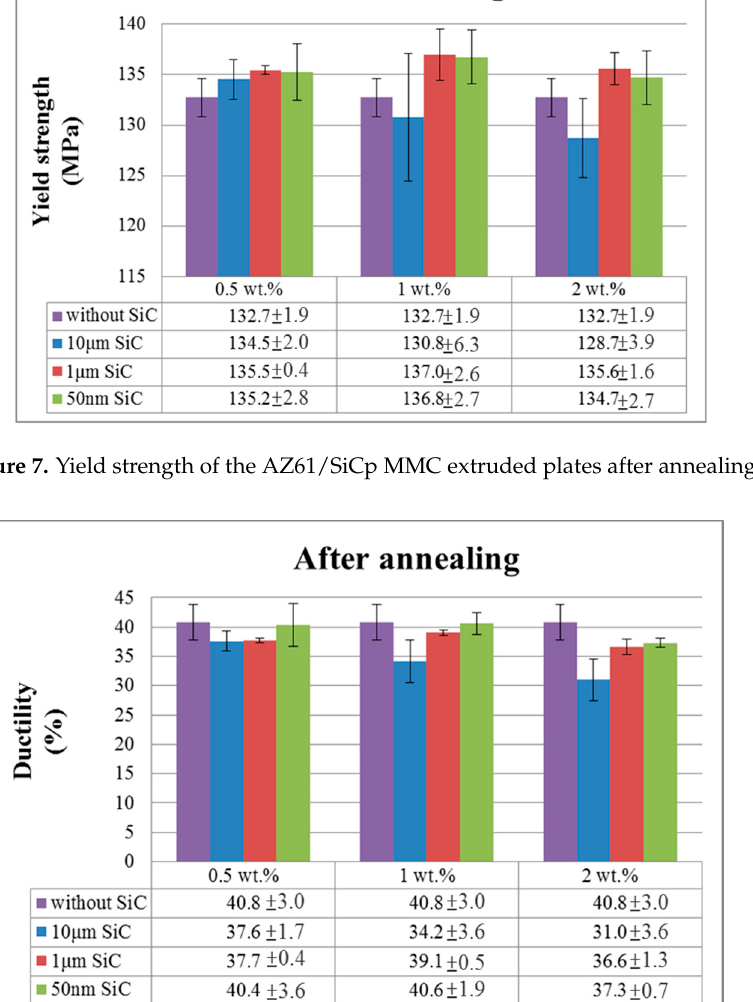
Figure 8. Ductility of the AZ61/SiCp MMC extruded plates after annealing.